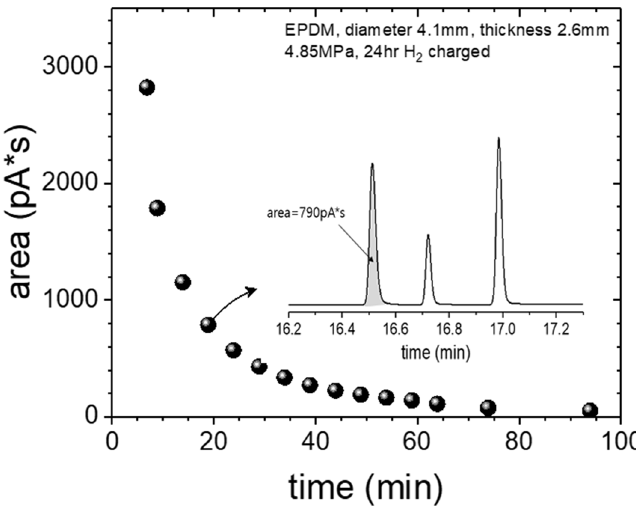
Figure 5. Measured GC signal intensity (area) against the elapsed time after decompression (sample: hydrogen charged EPDM for 24 h in 4.85 MPa